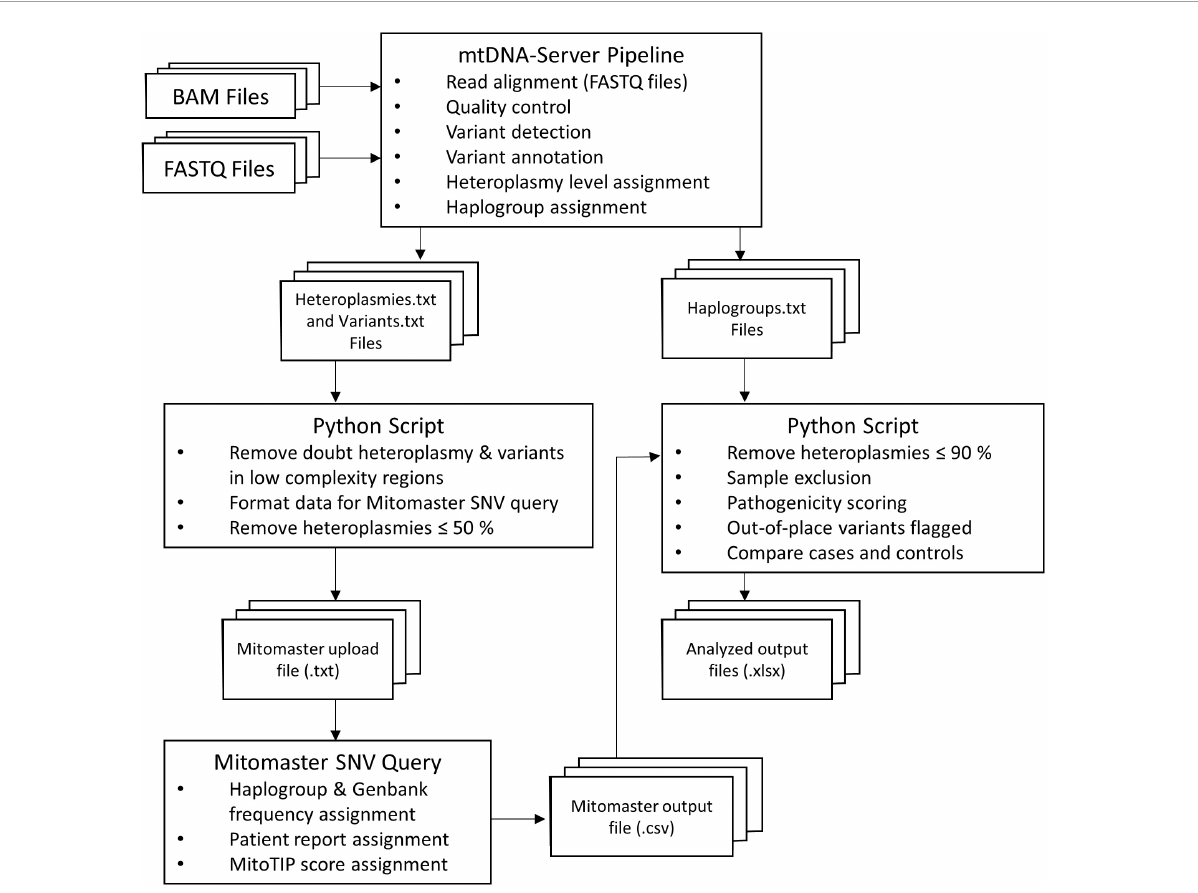
FIGURE2 Flow diagram outlining the data analysis process of the present study. The mtDNA-Server pipeline was used to process the BAM/FASTQ files containing mtDNA reads of the study participants. A Python script was used to filter mtDNA-Server variant files and prepare new variant files that could be uploaded to Mitomaster. Annotated variant files from Mitomaster, together with the previously generated mtDNA-Server haplogroup files were then used as input for a second Python script that tested the out-of-place variant